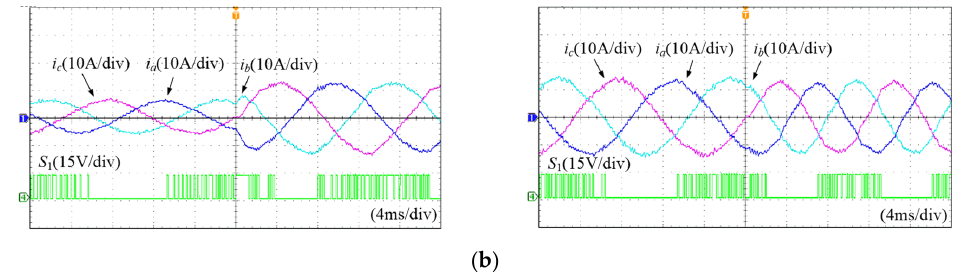
Figure 11. Experimental results of the three-phase output currents ( i a , i b , and i c ) and the a -leg upper switch S 1 for the current magnitude step change from 6 A to 12 A and frequency step change from 60 Hz to 90 Hz( | I * | = 12 A). ( a ) the proposed method with T s = 250 µ s, and ( b ) the conventional method with T s = 125 µ s.